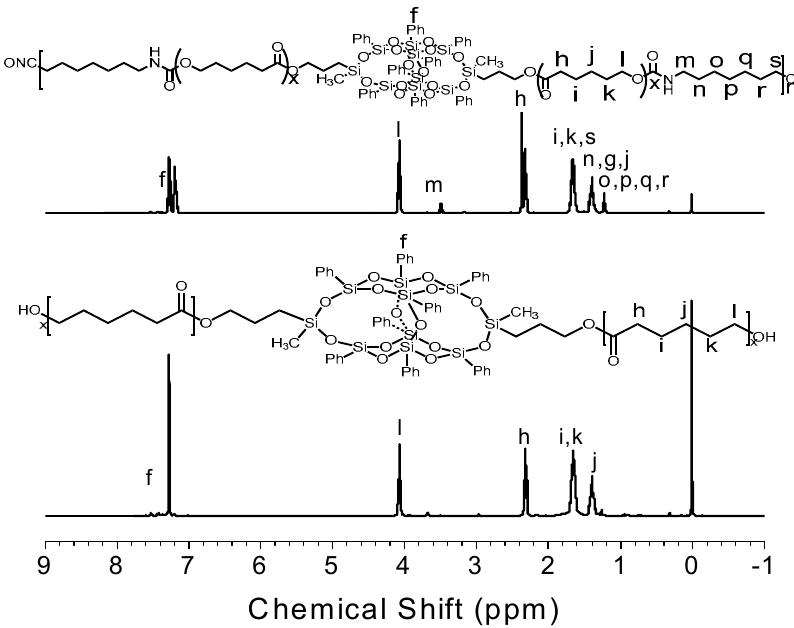
Figure 3. 1 H-NMR spectra of O-8000 and PU-8000 in CDCl 3 .